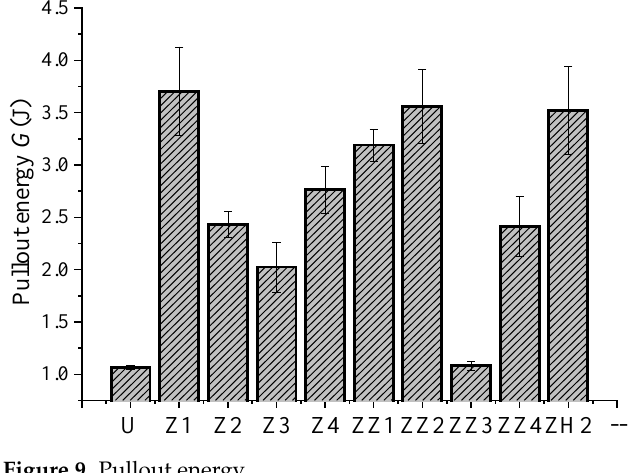
Figure 9. Pullout energy.